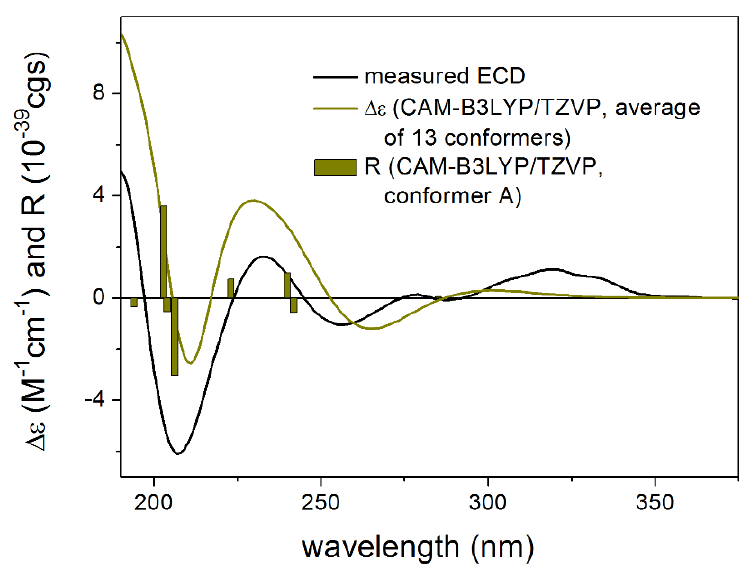
Figure 5. Comparison of the experimental ECD spectrum of 3 measured in MeCN with the CAM-B3LYP/TZVP PCM/MeCN spectrum of (6 R ,7 R ,8 S ,9 R ,10 R )- 3 (level of optimization: CAM- B3LYP/TZVP PCM/MeCN). The bars represent the rotational strength values of the lowest-energy conformer.